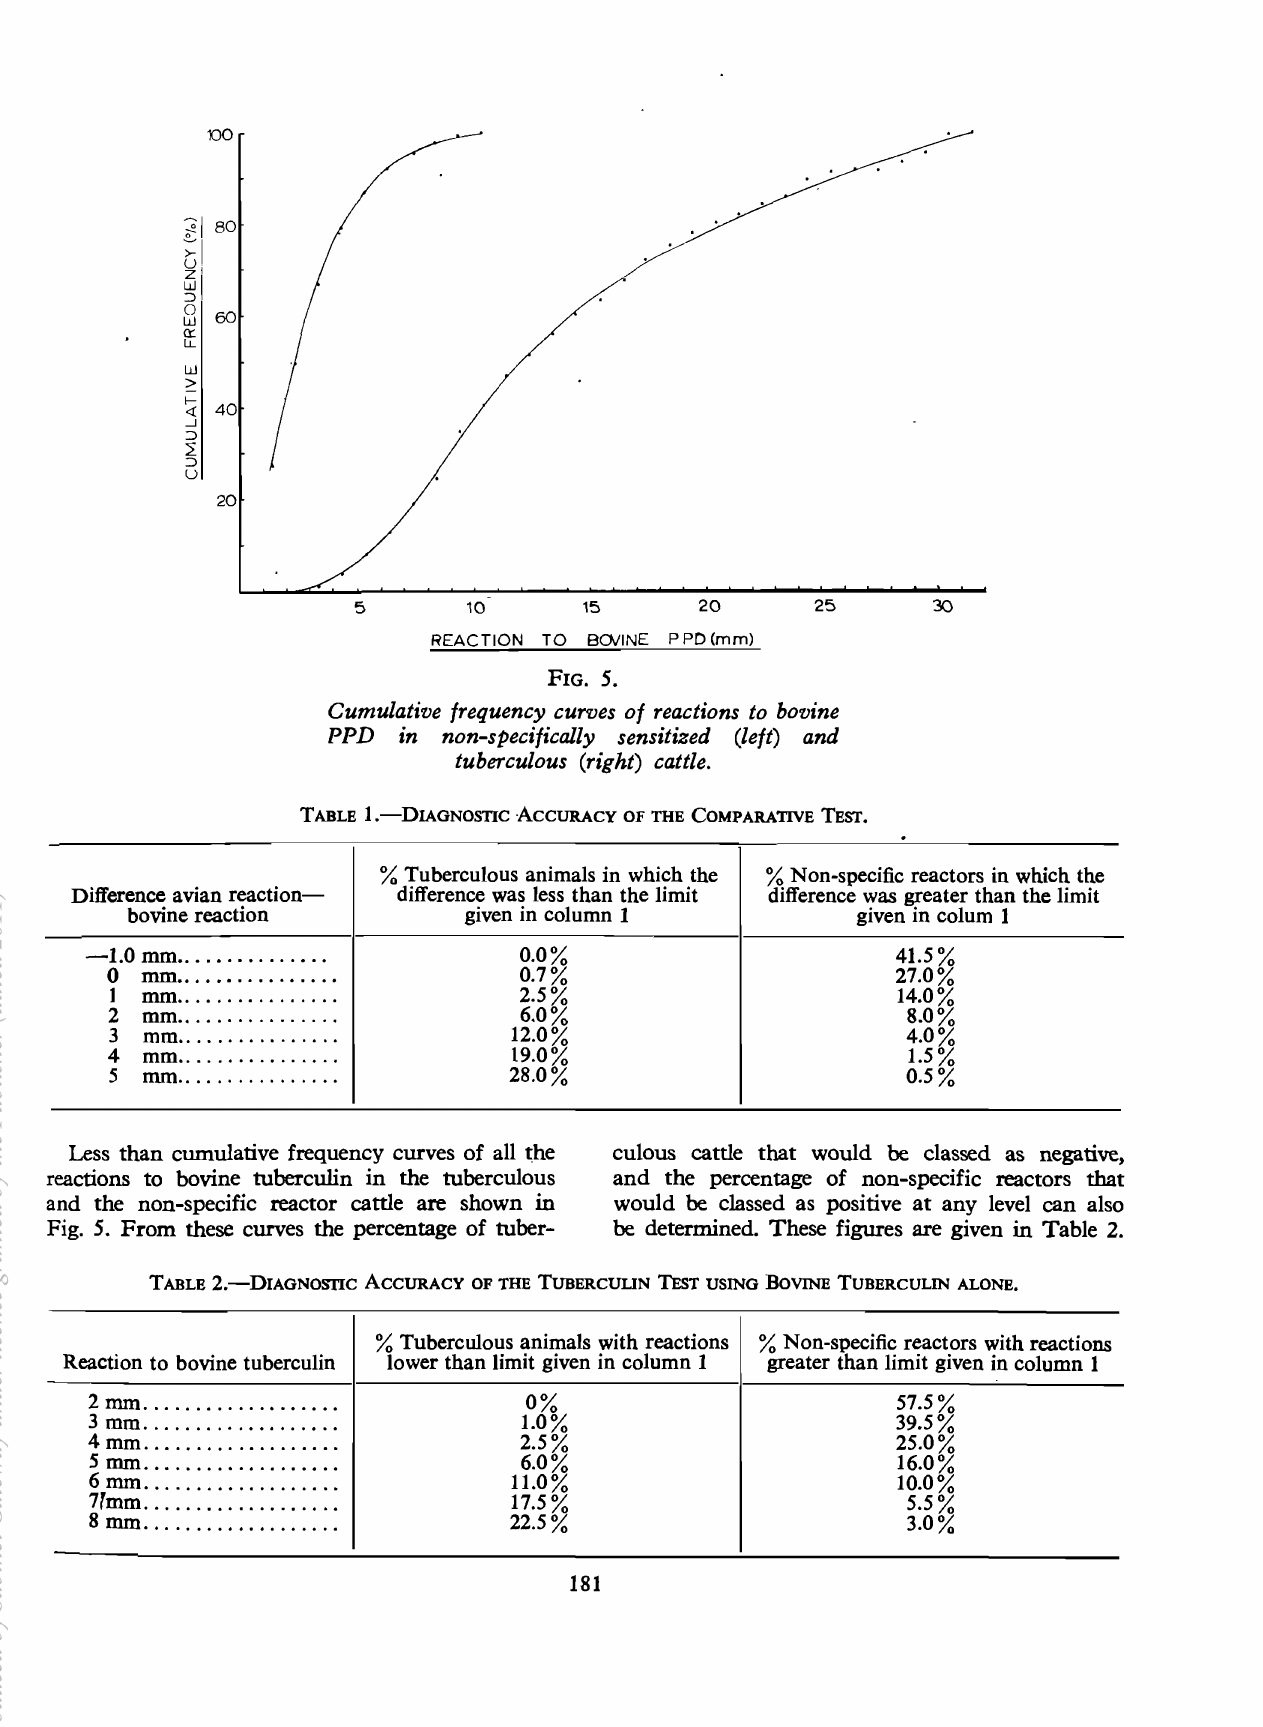
Reaction to bovine